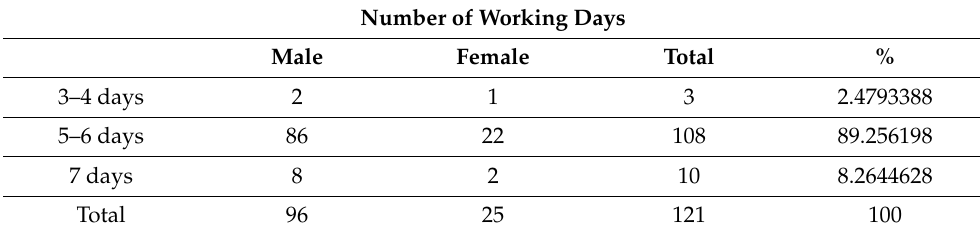
Table 4. Working hours of waste pickers in Lagos, Nigeria.